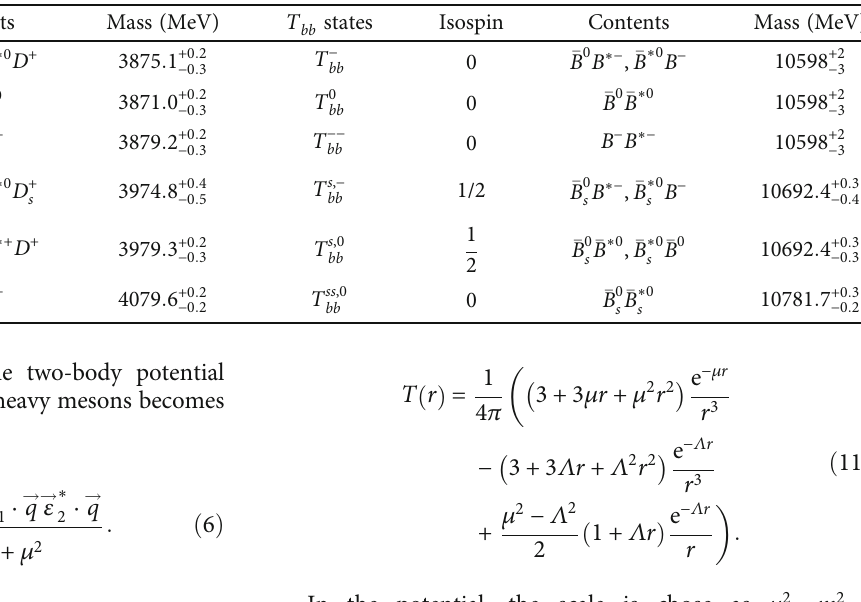
Table 1: Predictions of the masses (MeV) of HH ∗ stable hadronic molecules with spin-parity J P = 1 + . The uncertainty is from the choice of the e ff ective coupling g π = 0 : 5 ∓ 0 : 1